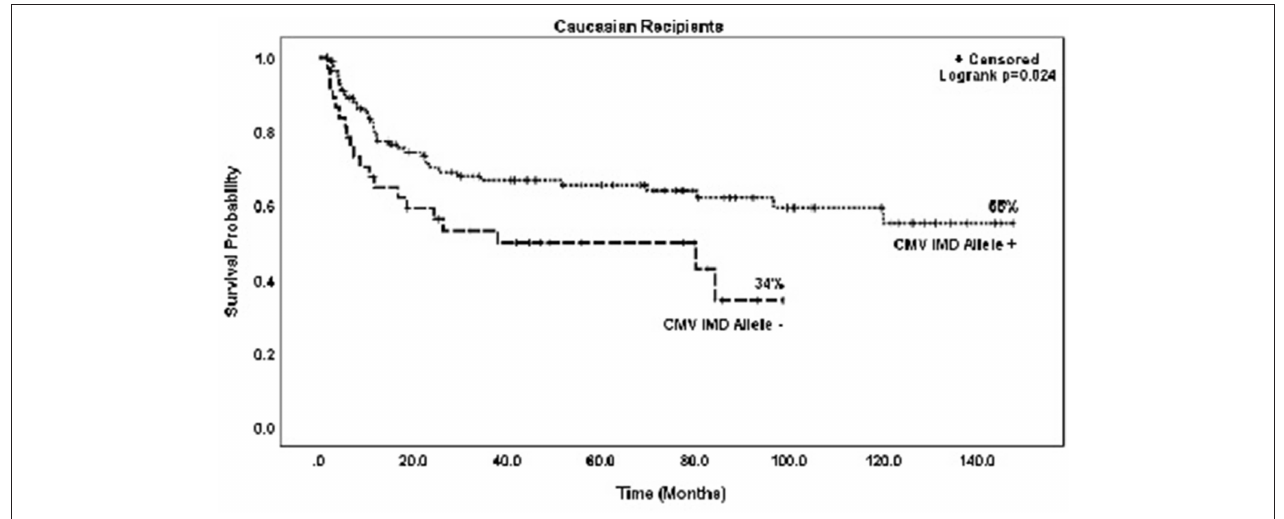
FIGURE 4 | Probability of survival in CMV + Caucasian patients based on the presence or absence of a CMV immunodominant